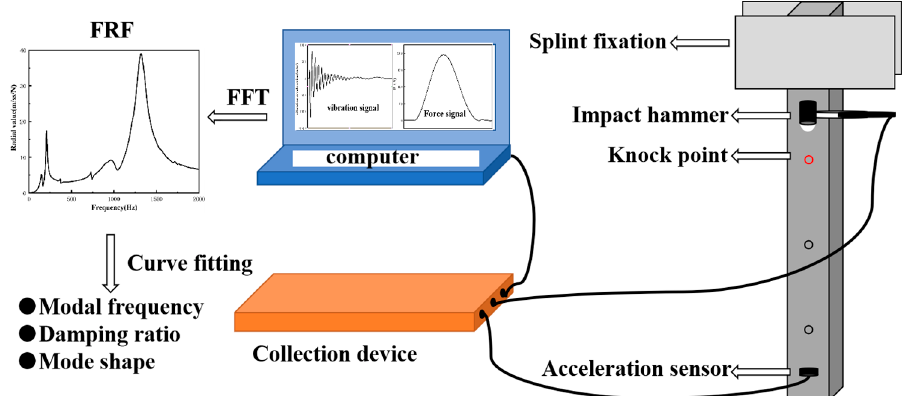
Figure 1. Experimental equipment of modal vibration test.